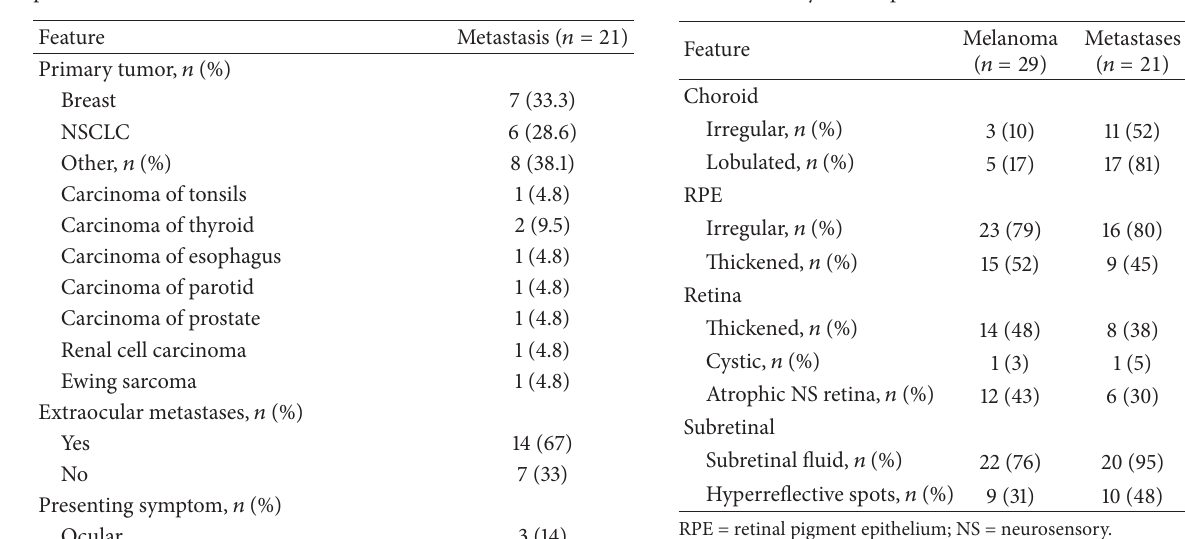
Table 3: Optical coherence tomographic features of choroidal tumors in 50 eyes of 50